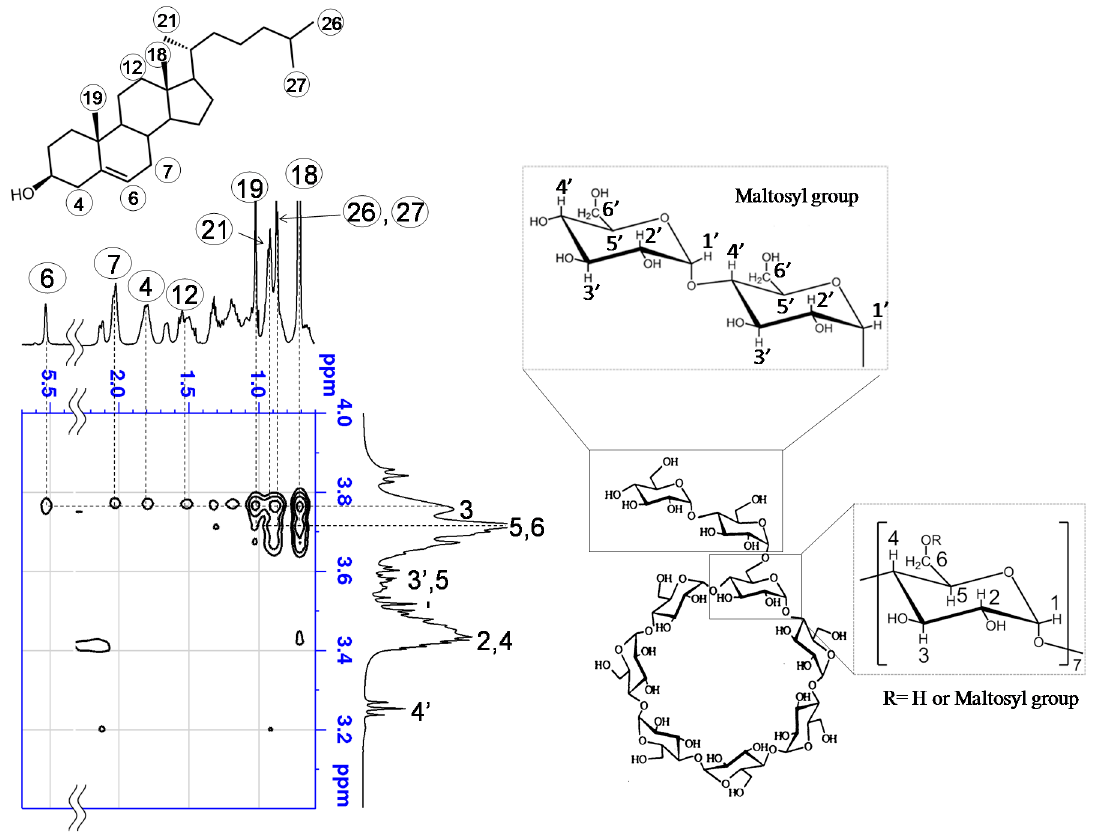
Figure 4. Two-dimensional 1 H-NMR Rotating frame Overhauser effect spectroscopy (ROESY) spectrum of the G2- β -CD and FC solution. G2- β -CD (100 mM) and FC was dissolved in D 2 O.